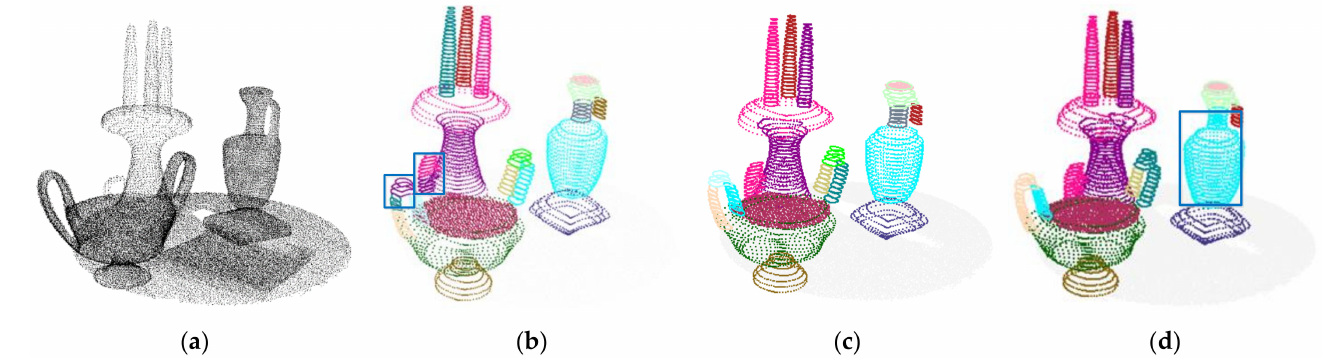
Figure 5. Experimental results of δ : ( a ) Scene 1; ( b ) δ = 0.38; ( c ) δ = 0.48; ( d ) δ =